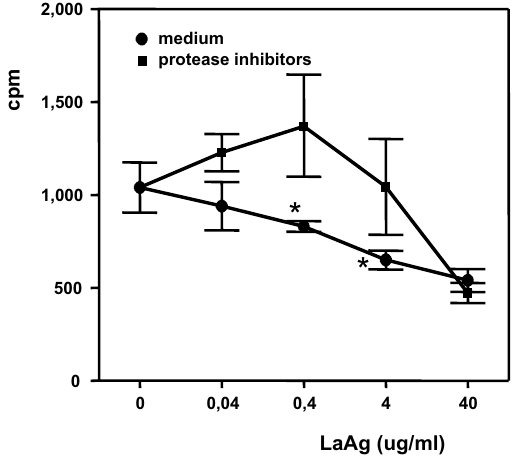
Fig. 2–EffectofLaAgpreparedwithproteaseinhibitorsonlym- phocyte cell proliferation. Cells from 7 day-infected mice were incubated with different concentrations of LaAg prepared in the presence or absence of protease inhibitors for 72 hours as de- scribed in Materials and Methods. Mean ± SD (n=3). Asterisks indicate p ≤ 0 , 01 in relation to the same concentration point.